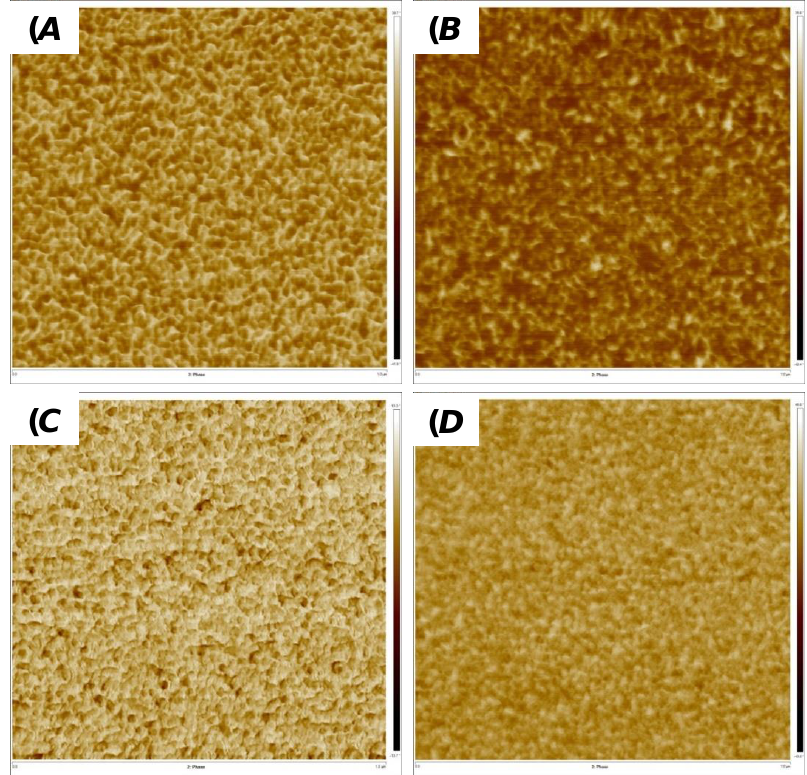
Figure 5. AFM images of the PVIm- l -PTHF-57 ( A ), PVIm- l- PTHF-76 ( B ), PVImMe- l -PTHF-57 ( C ), and PVImMe -l -PTHF-76 ( D ) conetworks (1000 × 1000 nm 2 ).